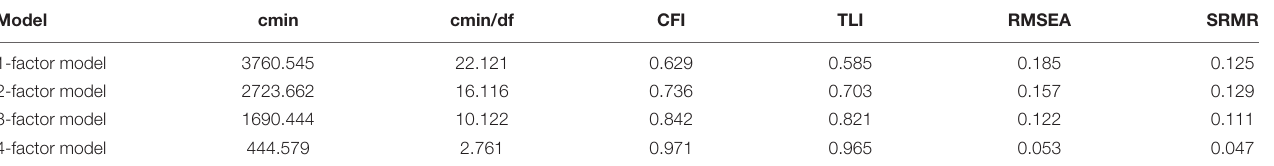
TABLE 3 | Results of common method